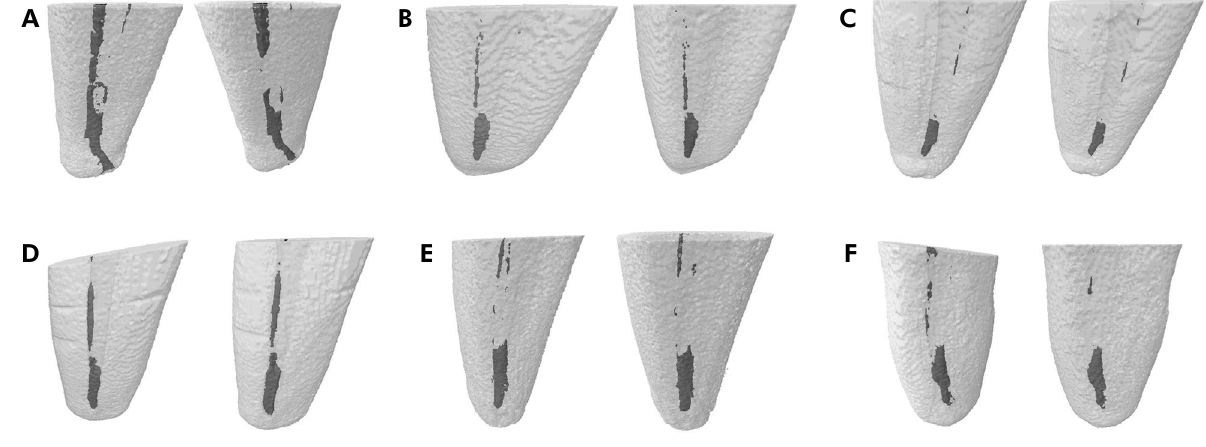
Figure 2. 3D models for residual filling material before and after the cleaning protocols: (A) NaOCl/MI, (B) NaOCl/PUI, (C) NaOCl/EC, (D) NaOCl/EDTA/MI, (E) NaOCl/EDTA/PUI, (F)